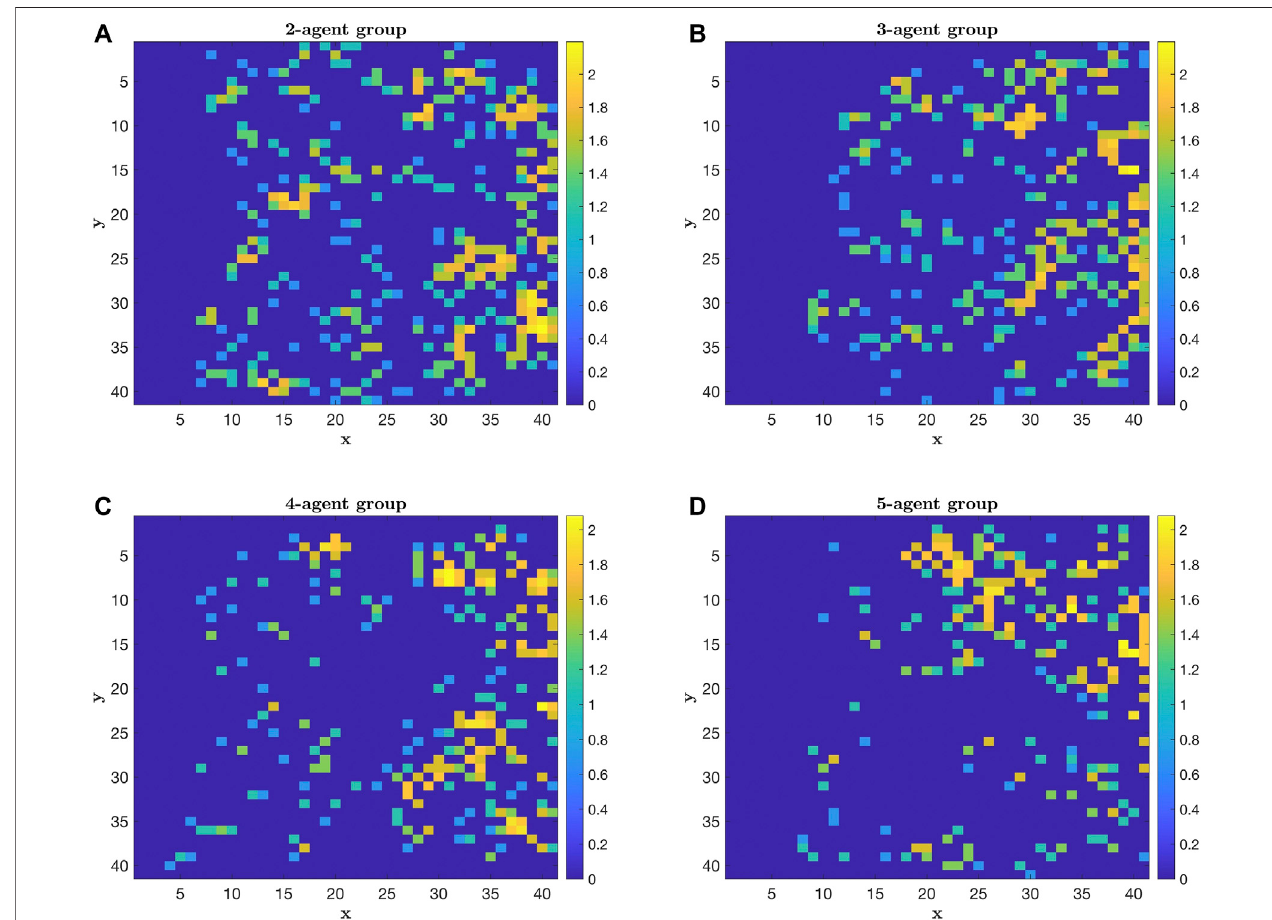
FIGURE11| Spatial distribution ofthe localmixingindex for 2-agent group (A) , 3-agent group (B) , 4-agent group (C) , and5-agentgroup (D) at themoment when the system mixing index reaches its maximum.